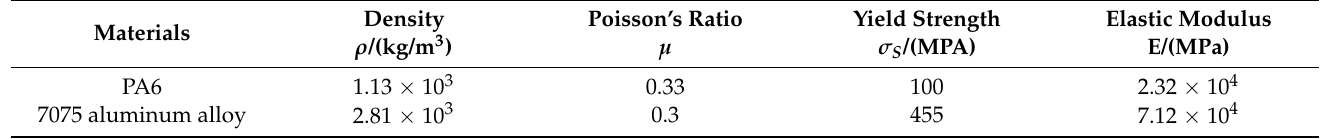
Table 2. Mechanical properties of PA6 (upper cover) and 7075 aluminum alloy (fixed base plate). Materials